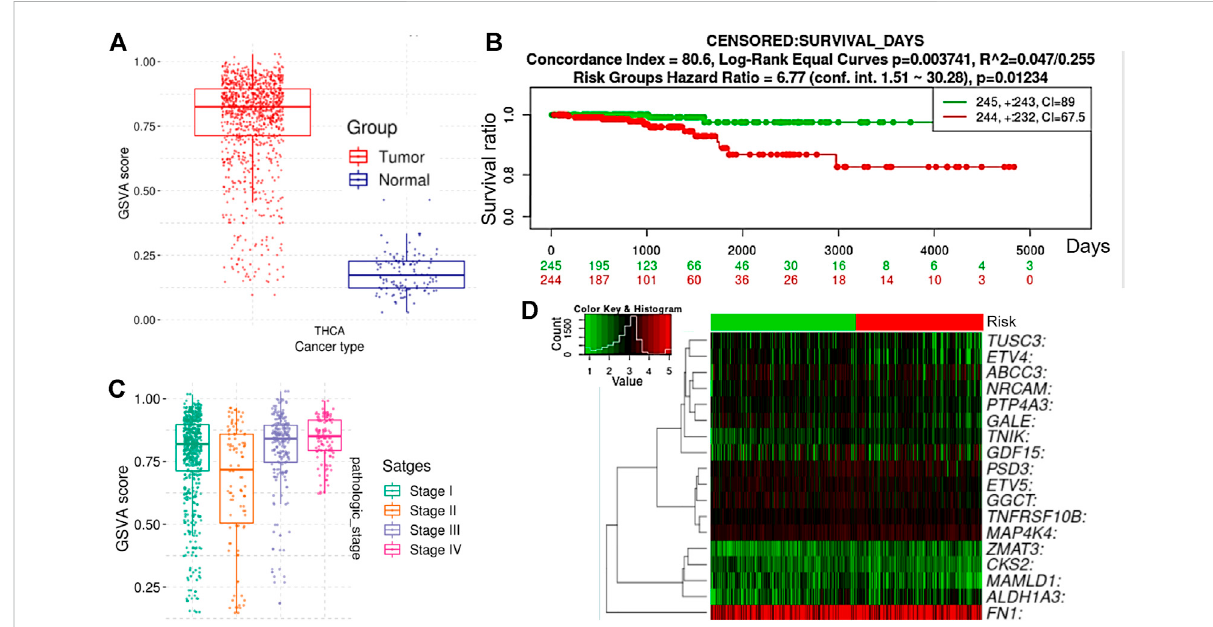
FIGURE 4 Gene enrichment analyses of the TTEPs from TCGA-PTC cohorts. (A) Bar plot of the gene set variation analysis (GSVA) score of TTEPs between TCGA-PTC cohorts and adjacent normal tissue. The GSVA is a GSE method that estimates the variation of pathway activity over a sample population inanunsupervisedmanner.Comparedtothenormal tissue,theTTEPsachievedaveryhighGSVAscore,whichshowsanegativeGSVAscoreinPTC. (B) Bar plots of the differential GSVA score between tumor stages. (C) Kaplan – Meier plot, and (D) risk plot of TCGA-PTC cohorts with high and low-expressionpro fi lesofTTEPs.ThePTCcohortswithhighexpressionlevelsofTTEPsexhibitedhighhazardriskandshortersurvivaldurationwhen compared with cohorts with low expression levels of the